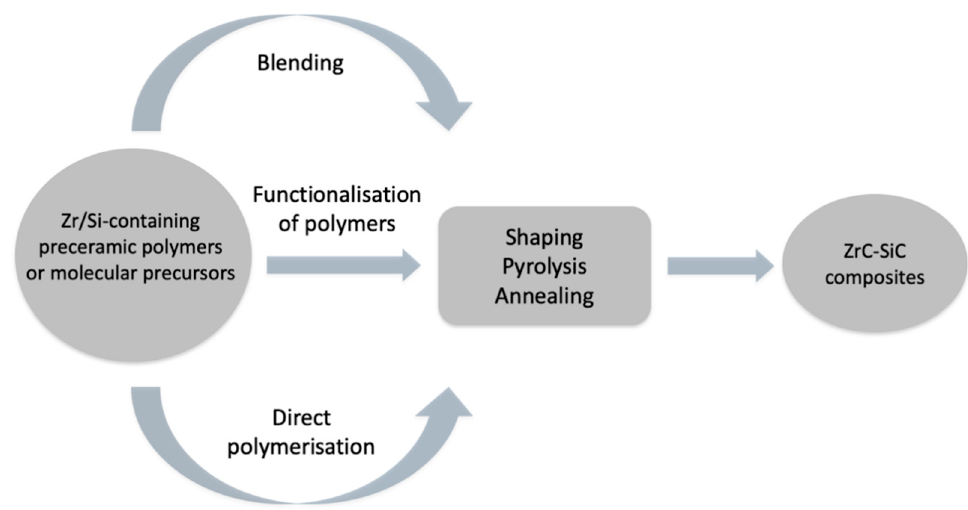
Figure 1. A summary of different strategies described to obtain ZrC–SiC composites using the PDCs route